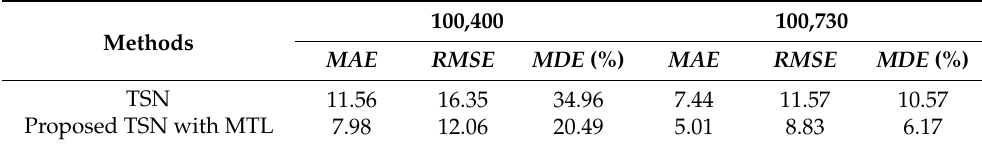
Figure 3. Comparison of density maps estimated by CRSNet and our proposed TSN. Table 2. The performance comparison on camera 100,400 and camera